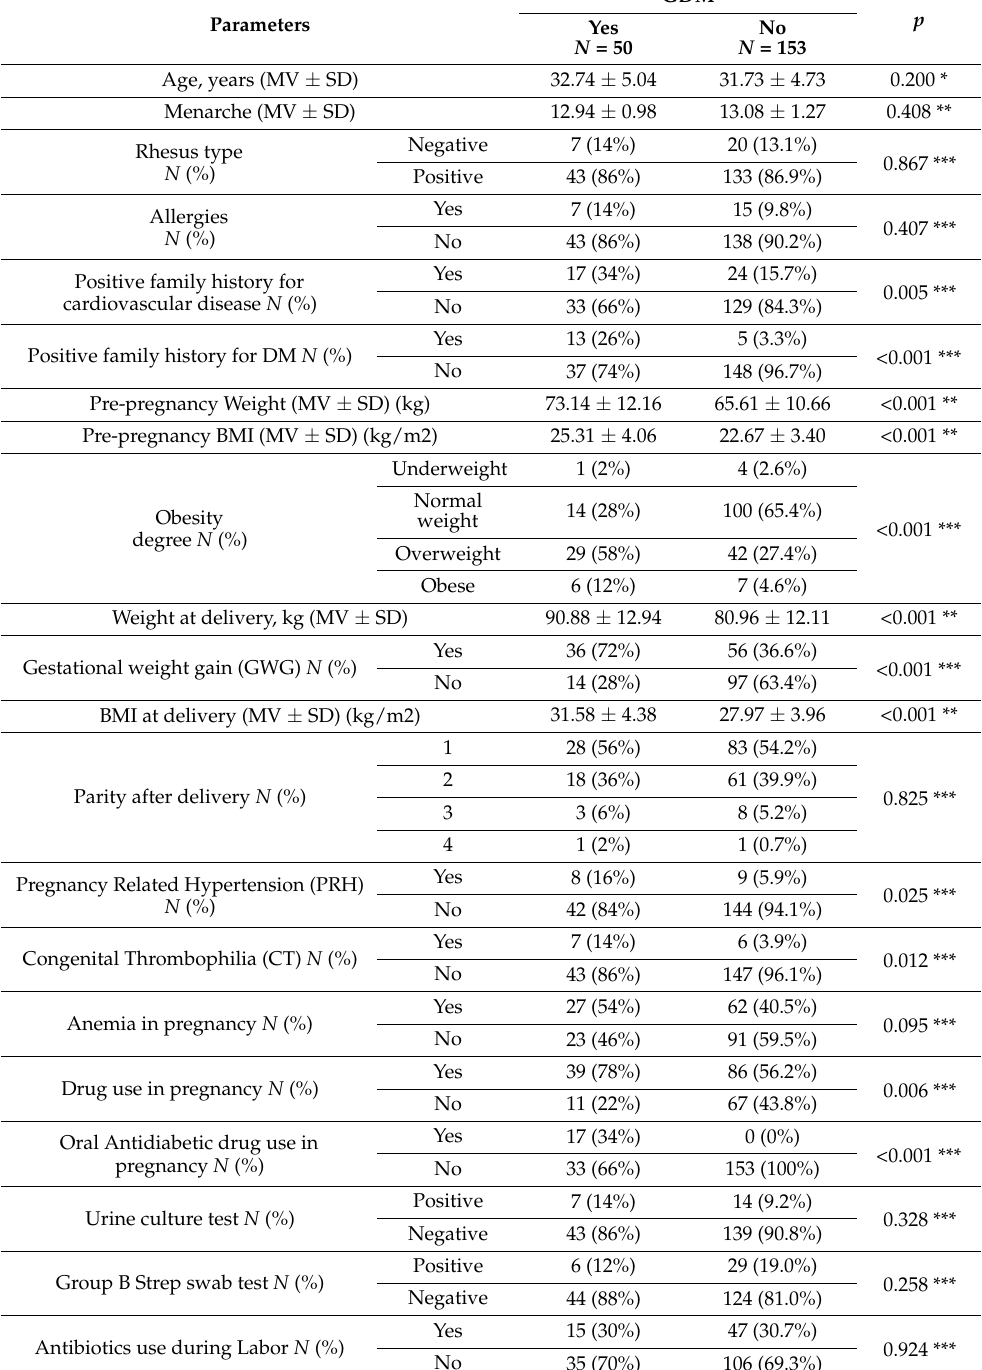
Table 1. Maternal parameters characteristics according to GDM presence ( N =